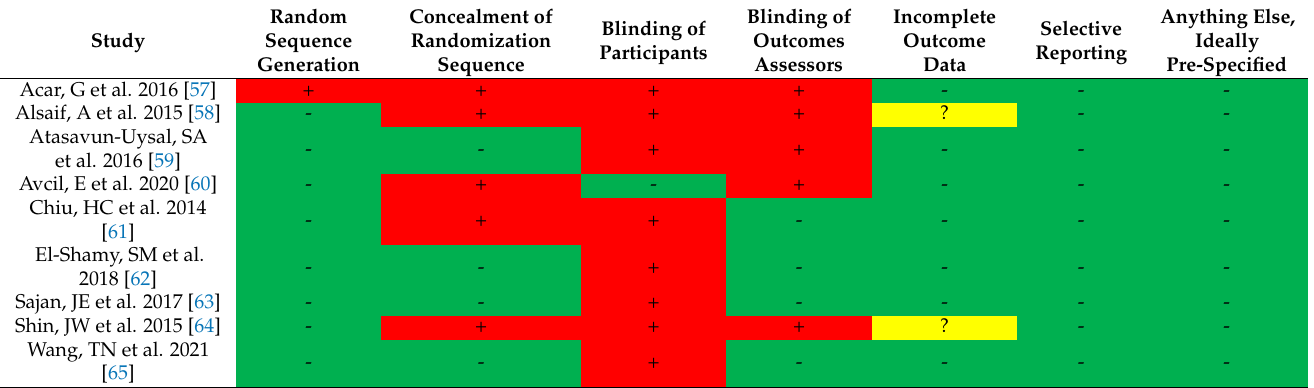
Table 4. Risk of bias in the studies included in the